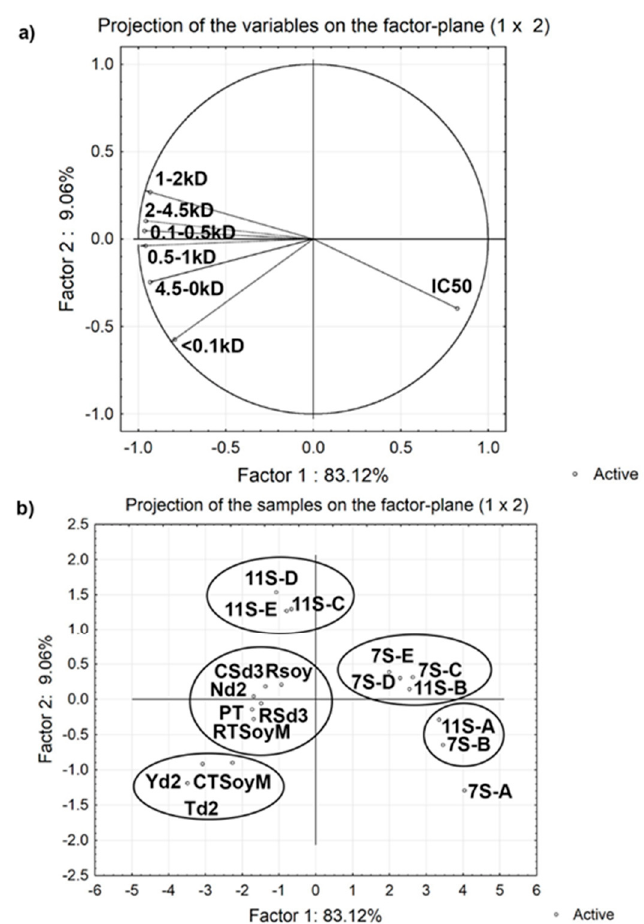
Figure 3. Scatterplots of the principal component analysis (PCA): ( a ) representing 8 variables and ( b ) representing 9 soybean foods, 5 hydrolysates of 7S and 5 hydrolysates of 11S. RSoy: raw soybean; RTSoyM: raw traditional soymilk; CTSoyM: cooked traditional soymilkPT: pressed tofu; RSd3: raw sprout germinated for 3 days; CSd3: cooked sprout germinated for 3 days; Nd2: natto stored for 2